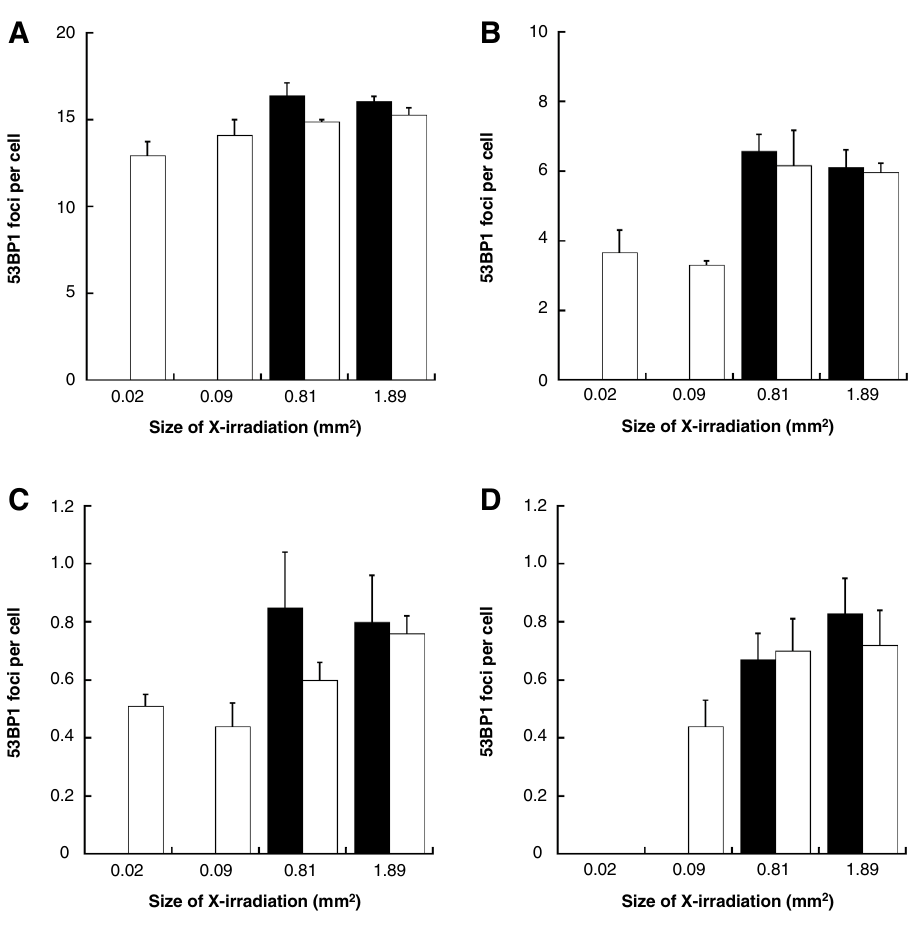
Figure 4. X-irradiated field area distribution of cells with DNA damage in the cell population. The X-irradiated field sizes of 0.81 mm 2 and 1.89 mm 2 were divided into 0.3 mm × 0.3 mm, and the X-irradiated field area distribution of cell with DNA damages in cell population was analyzed at 1 h ( A ), 4 h ( B ), 24 h ( C ), 48 h ( D ), post-irradiation. After that, we investigated the number of 53BP1 foci as DSB per cell in cells located in area having not contact (black bar) or contact (white bar) with non-irradiated area of a cell population. Since the areas with X-irradiated field seizes of 0.02 mm 2 and 0.09 mm 2 are totally in contact with non-irradiated area, there is no data for the area in not contact with non-irradiated area. The data were pooled from three or four independent experiments and the results were represented as mean ± standard error. These figures were created with KaleidaGraph